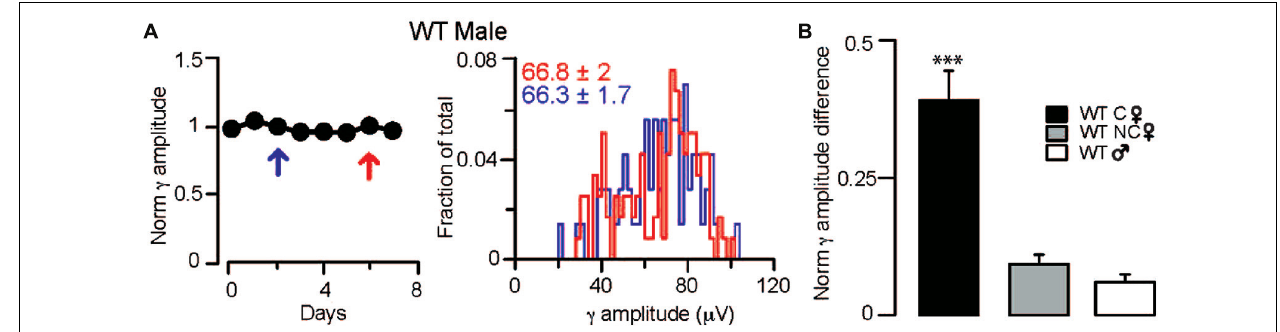
FIGURE 3 | Fluctuations in γ oscillation amplitudes recorded during REM sleep are absent in males and non-cycling WT females. (A) Left : diagram showing normalized γ amplitudes during REM sleep on consecutive days in a WT male mouse. Right : distribution of γ amplitudes (binned at 2 μ V) in all REM phases recorded on two separate measurements taken 3 days apart. The 2 days are indicated on the left with red and blue arrows. Colored numbers indicate mean ± SEM of the corresponding γ amplitude histograms. (B) Summary data showing the